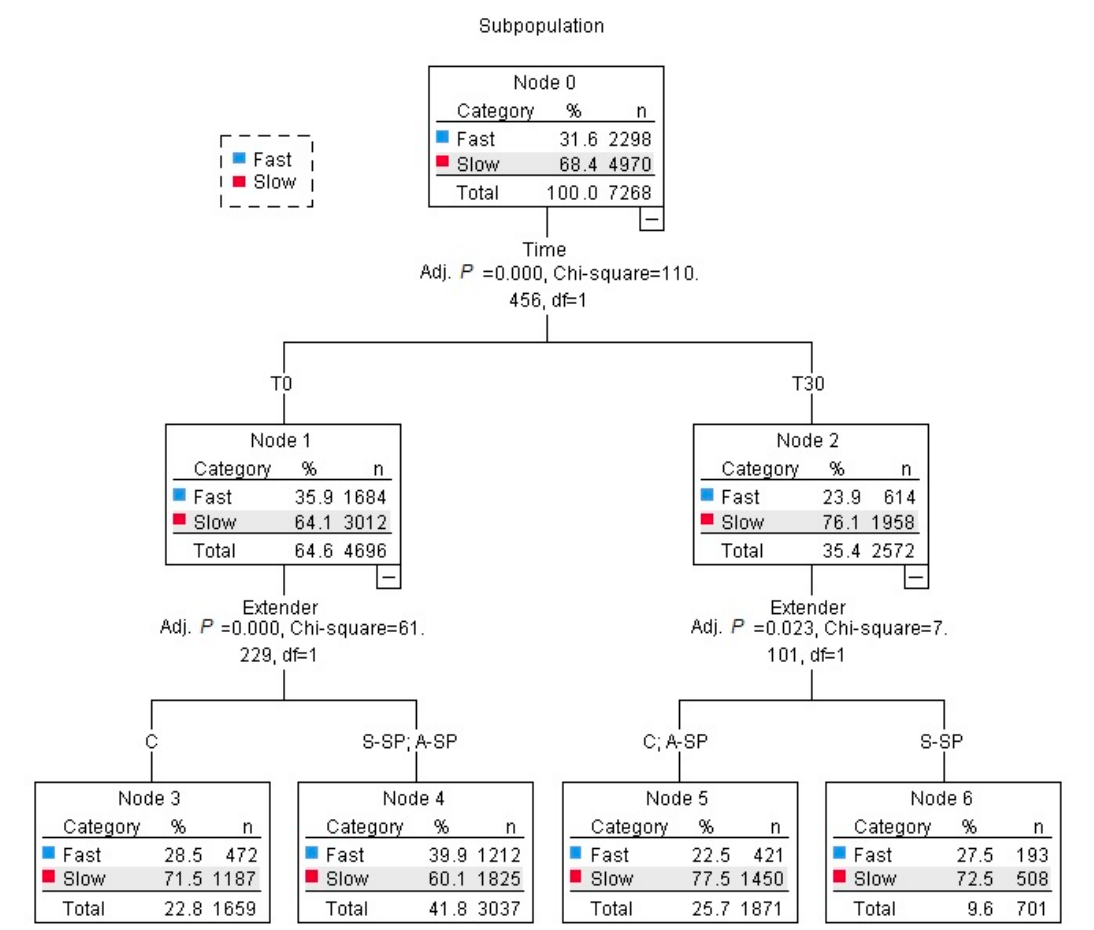
Figure 1. E ff ect of seminal plasma addition on the distribution of spermatozoa into slow and fast subpopulations after thawing and after 30 min of incubation.